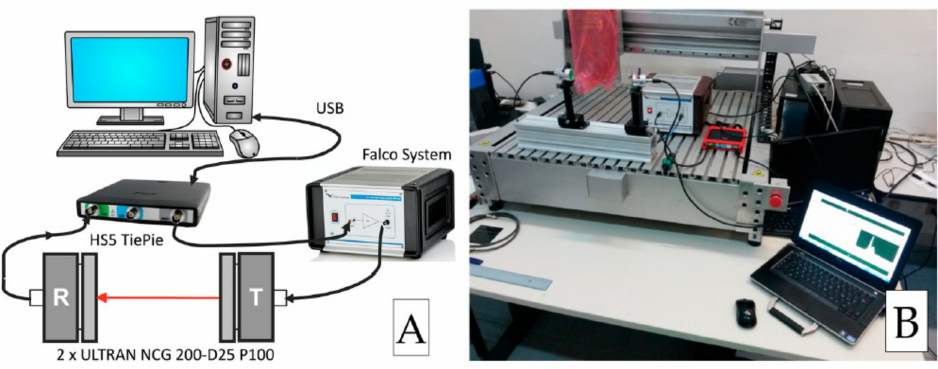
Figure 7. Schematic representation ( A ) and image ( B ) of the Ultrasonic non-contact